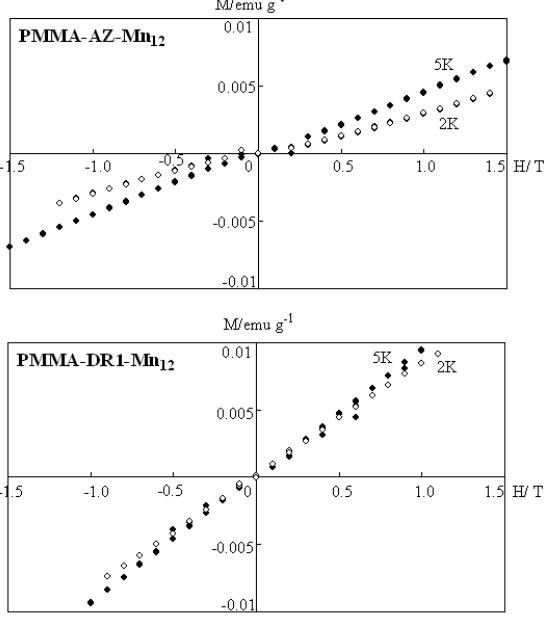
Figure 3. PMMA-AZ-Mn and PMMA-DR1-Mn 12 dependence (filled and empty circles for 5 and 2 K, respectively).